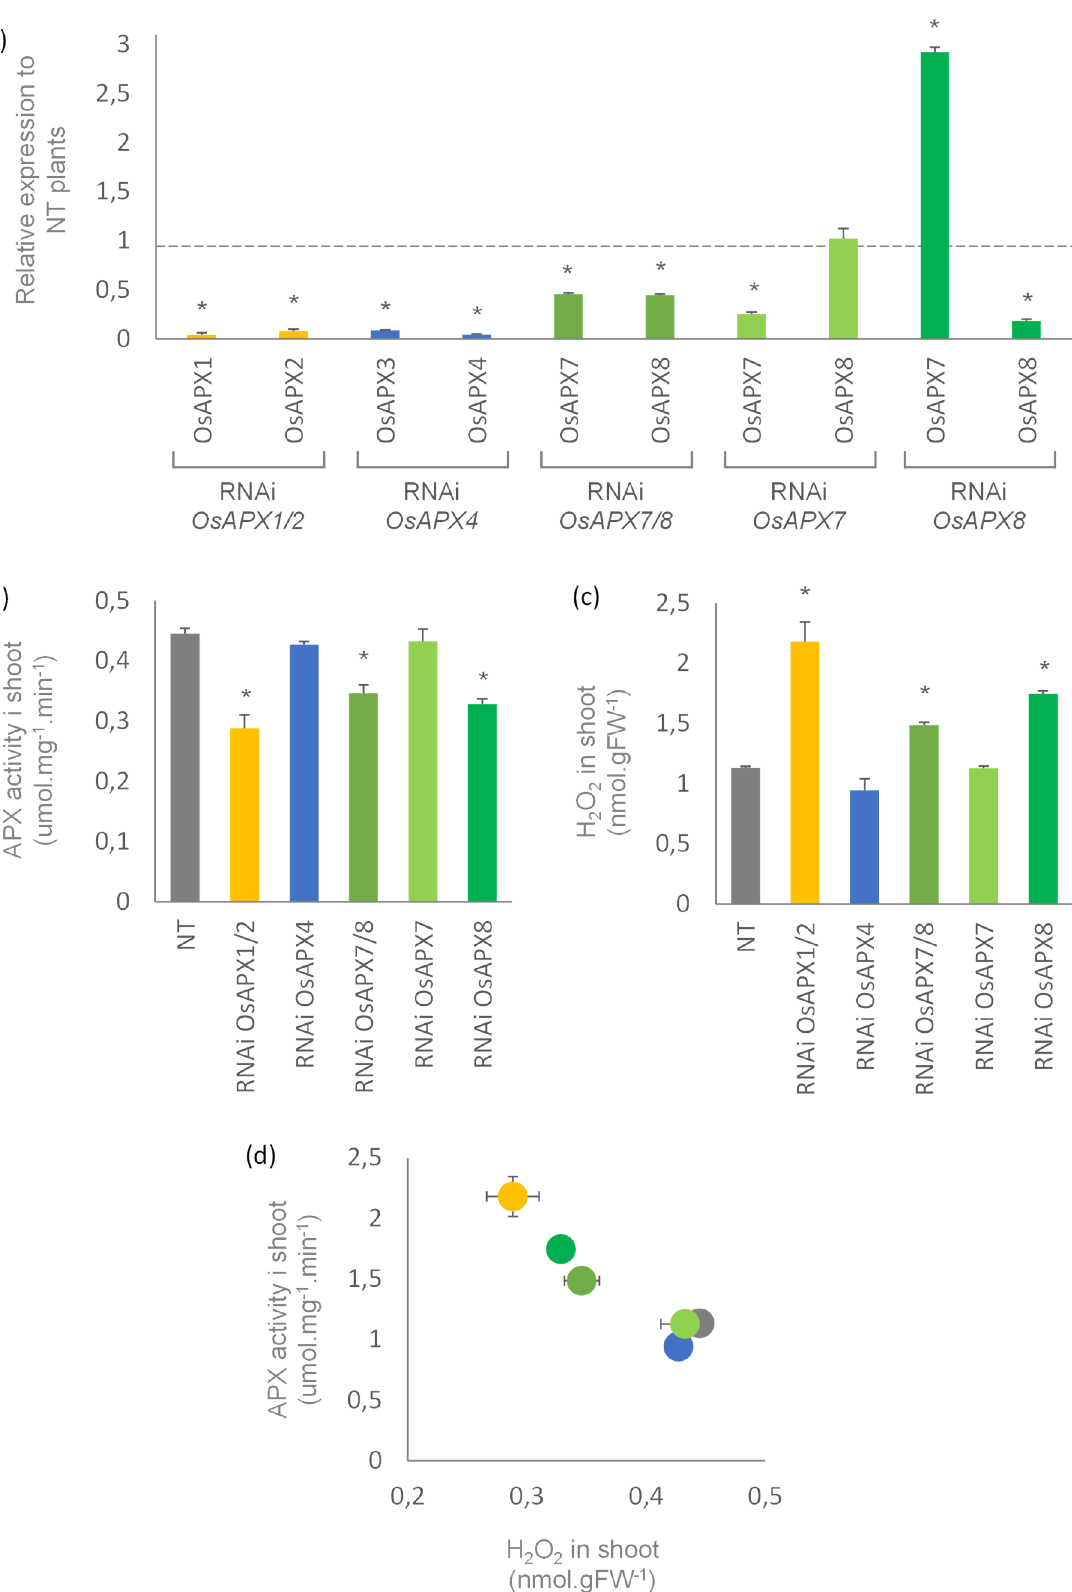
Figure 7 – APX activity and hydrogen peroxide content in shoots from rice plants silenced to cAPX, pAPX and chlAPX isoforms. (A) Quantitative determination of APX expression in shoots from RNAi OsAPX1/2, RNAi OsAPX4, RNAi OsAPX7/8, RNAi OsAPX7 and RNAi OsAPX8 plants. The values are expressed relatively to NT plants. (B) Measurement of APX activity in shoots from NT and silenced plants. (C) Hydrogen peroxide content in shoots from NT and silenced plants. (D) The relationship among the APX activity and hydrogen peroxide content in shoots from all plants analyzed. The values represent the media ± SE of at least three independent